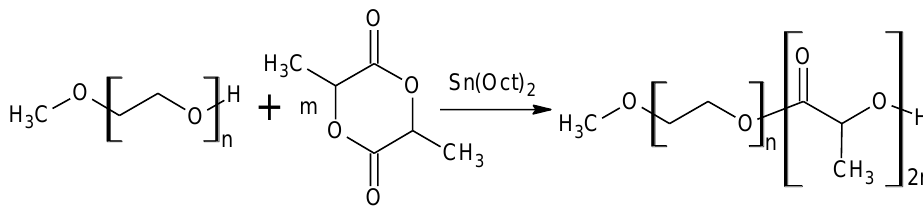
Figure 1. The preparation and development of properties of polylactide composite materials filled with hydroxyapatite. with hydroxyapatite.